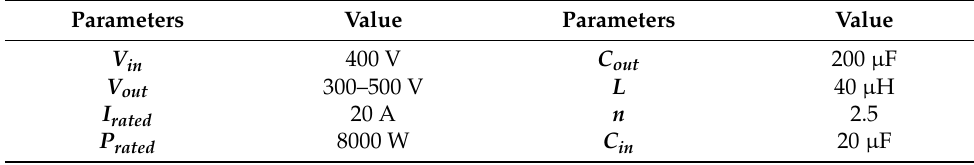
Table 1. Parameters of the EPBC.